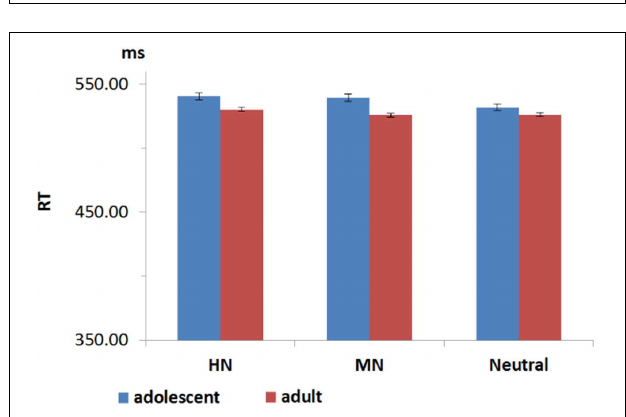
FIGURE 3 | The reaction time (RT) for adults and adolescents during HN, MN, and Neutral